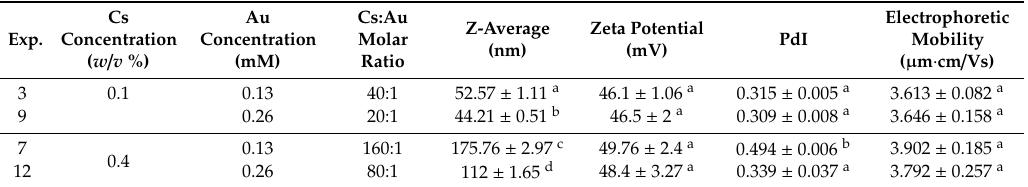
Table 3. Physical parameters of the Cs-AuNPs synthesized with MM w chitosan in experiments 3 − 9 and 7 − 12.